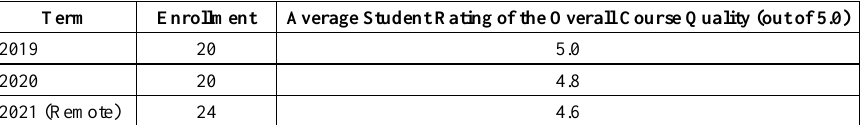
Table 1. Results of first 3 offerings of Introduction to Systems